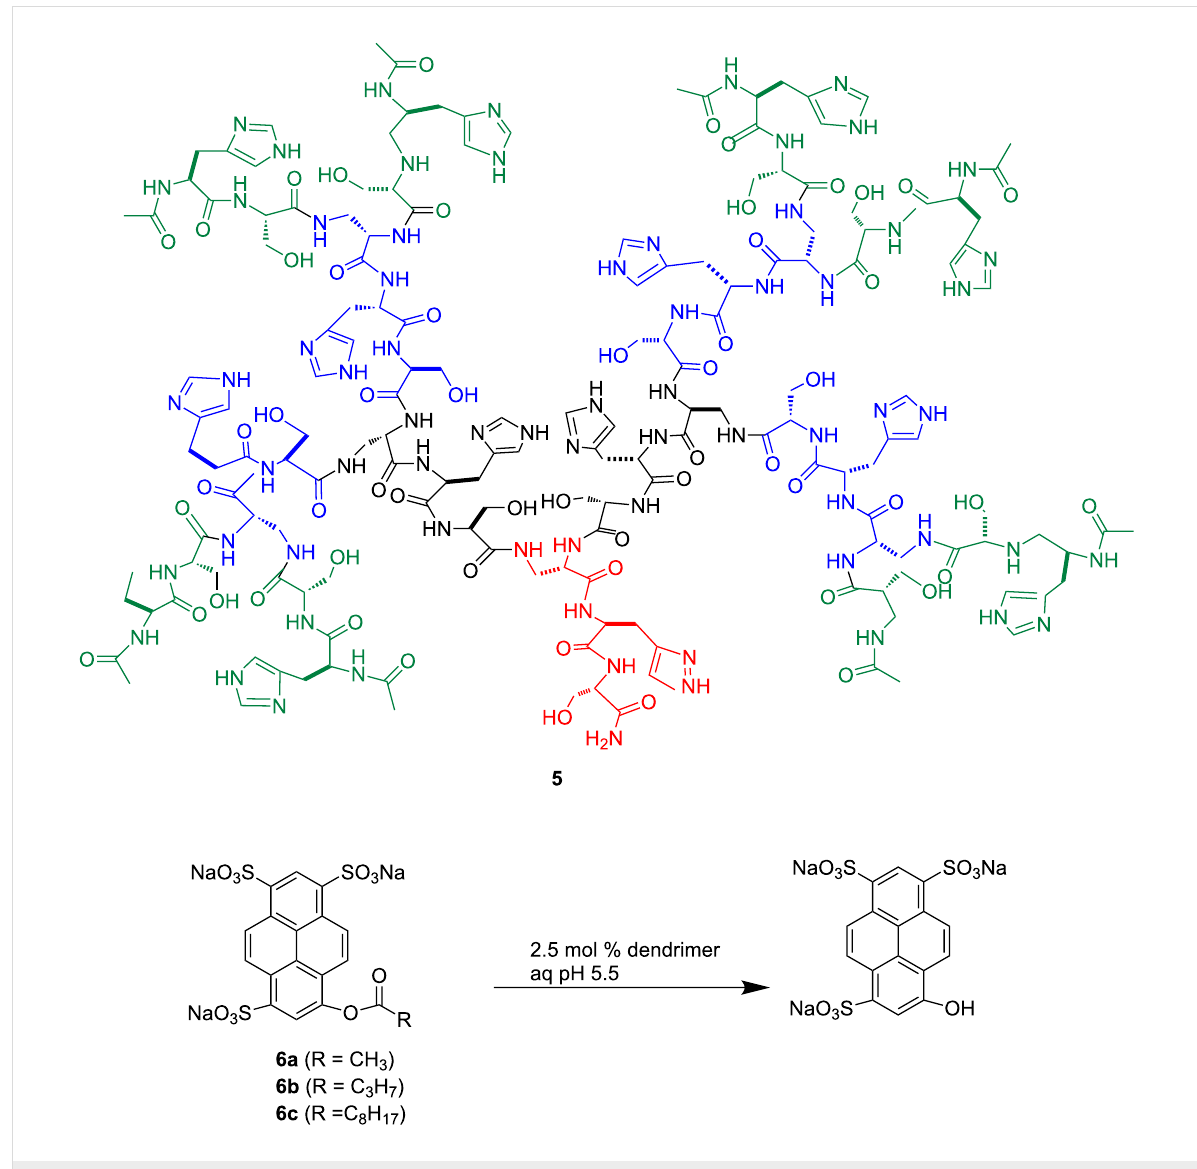
Figure 7: The multivalent esterase dendrimer 5 catalyzes the hydrolysis of 8-acyloxypyrene 1,3,6-trisulfonates 6a – c . Reprinted with permission from [105].